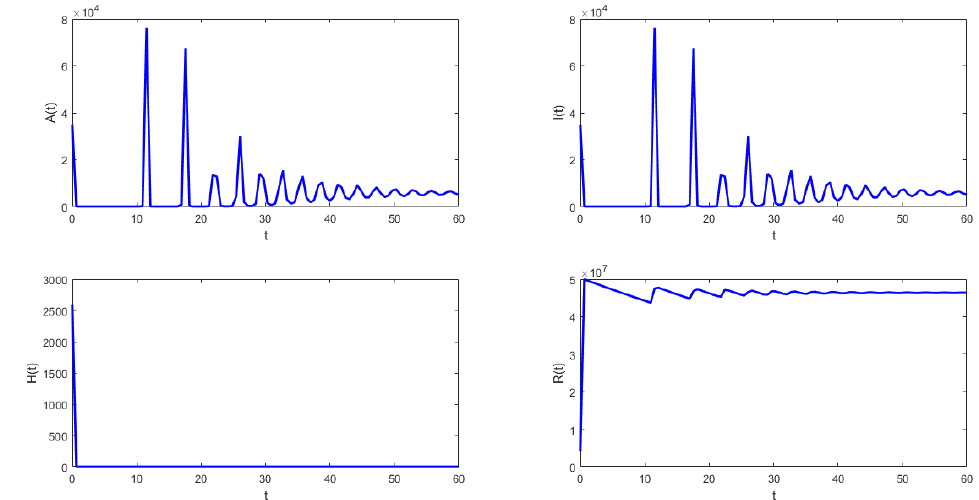
Figure 4. Numerical simulation of system (1) with the following values for the parameters: β I = 0.16 × 10 − 4 , β A = 0.16 × 10 − 4 , ν 1 = 0.15, ν 2 = 0.1, τ = 0.1 < τ ∗